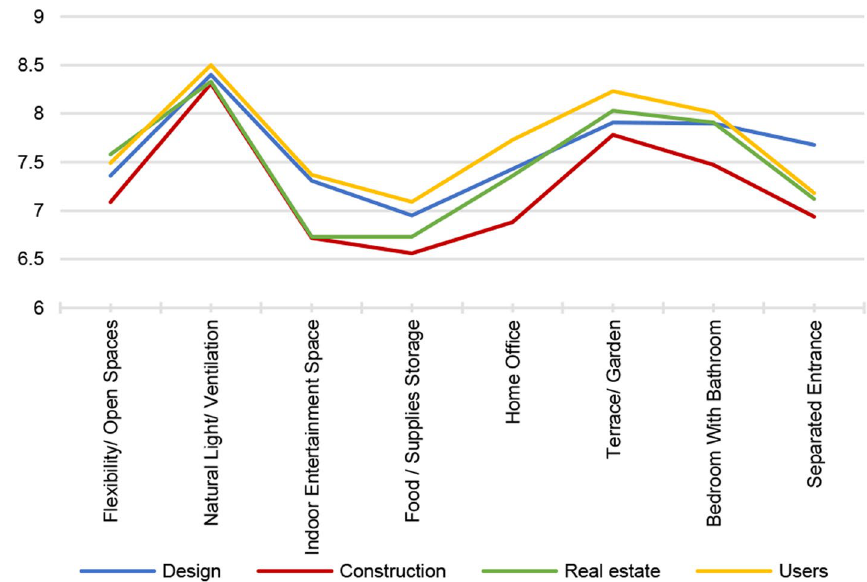
Fig. 5 Perceived importance levels per occupation. Ref: researchers